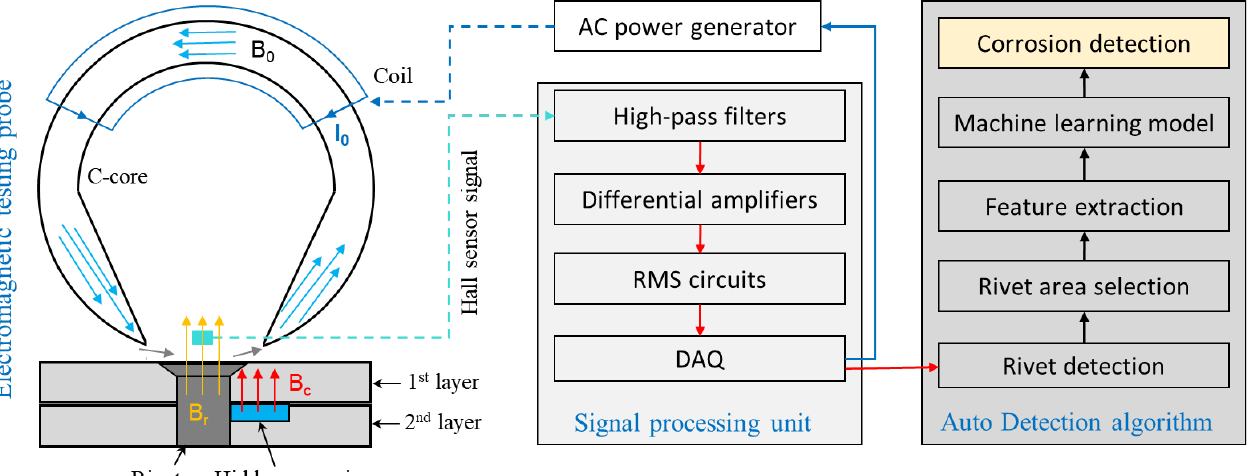
Figure 1. Principle of the electromagnetic testing system with the integration of machine learning techniques.